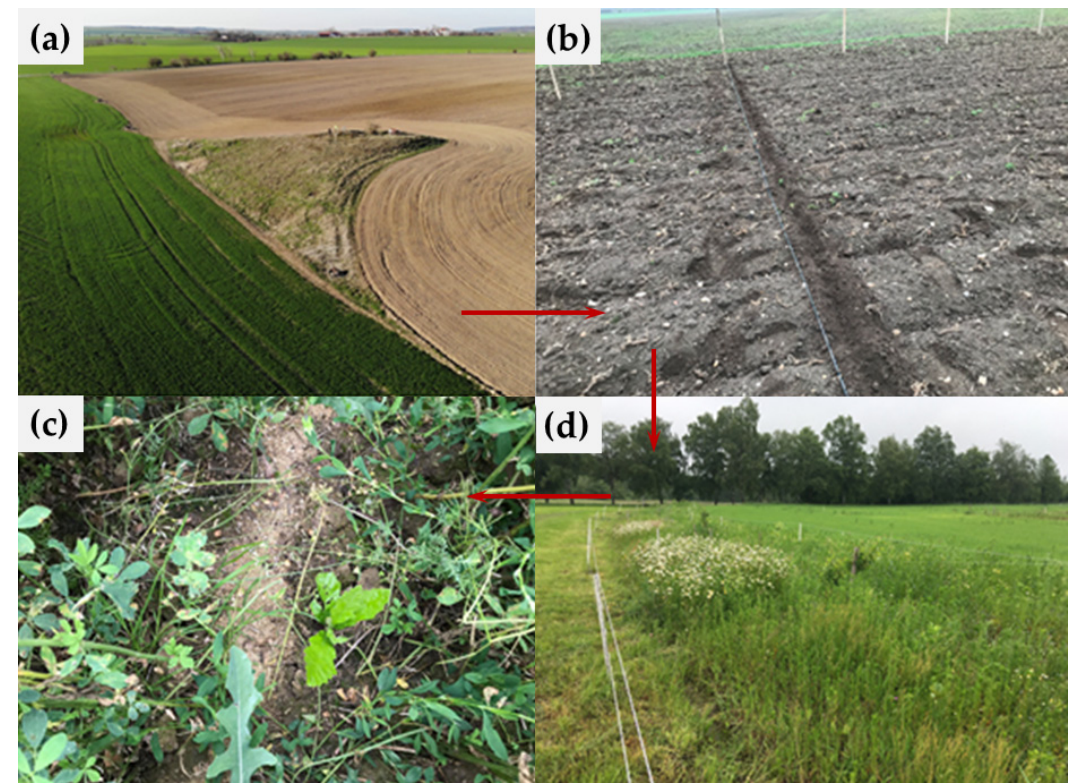
Figure 2. The localities and bosks during the time: ( a ) T ř ebelovice—locality before planting, April 2018, ( b ) Kyjovice— sowing row, March 2019; ( c ) Blížkovice—sessile oak ( Quercus petraea (Matt.) Liebl.) seedling, August 2020; ( d ) Kameni č ky—lower part of the bosks with blooming meadows, July 2020.